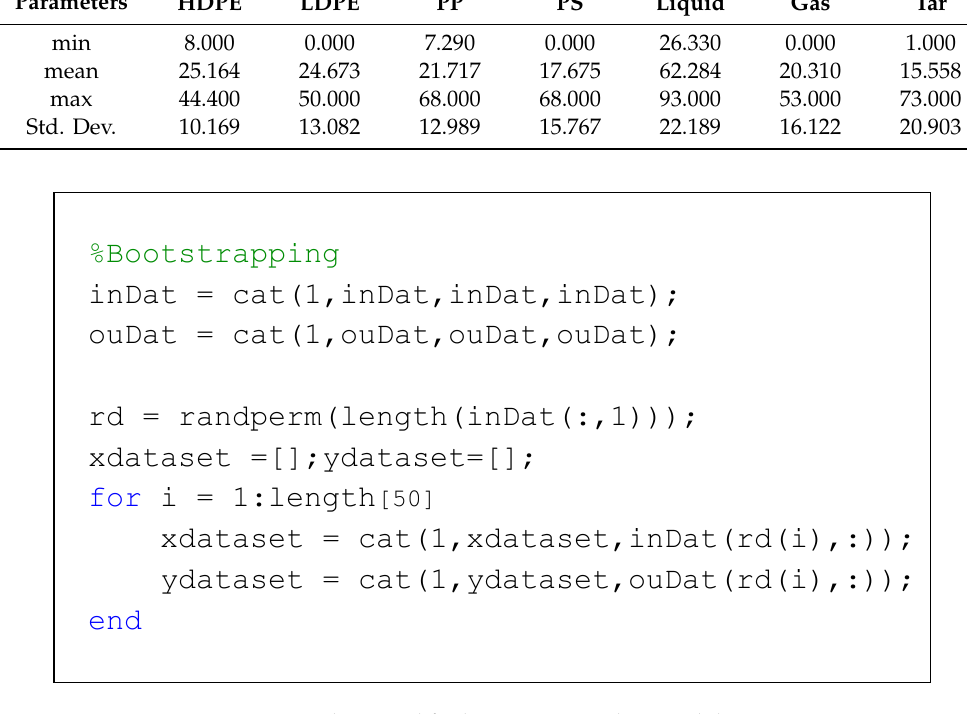
Figure 2. Coding used for bootstrapping the initial dataset.